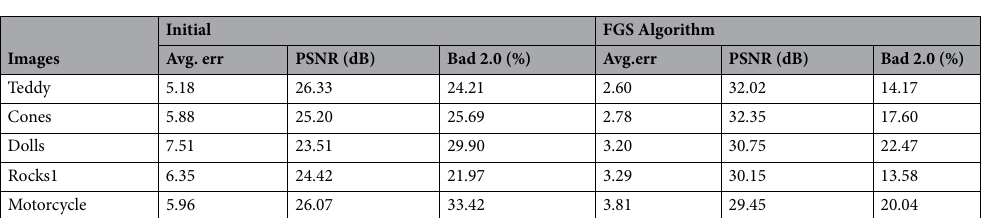
Table 3. Performance measures of the FGS algorithm for selected Middlebury stereo pairs without post- processing the disparity maps. Disparity estimates in the occluded regions were not excluded in the final disparity maps. FGS estimates significantly improved over the initial disparity estimates by all performance metrics.